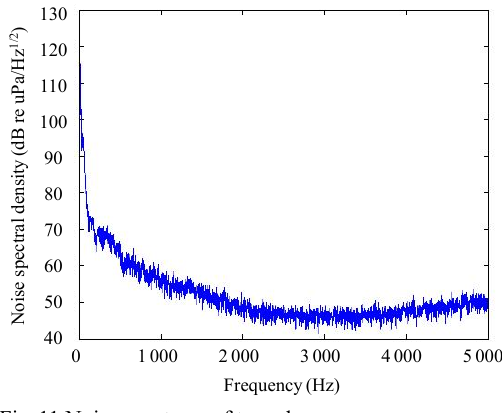
Fig. 11 Noise spectrum of towed